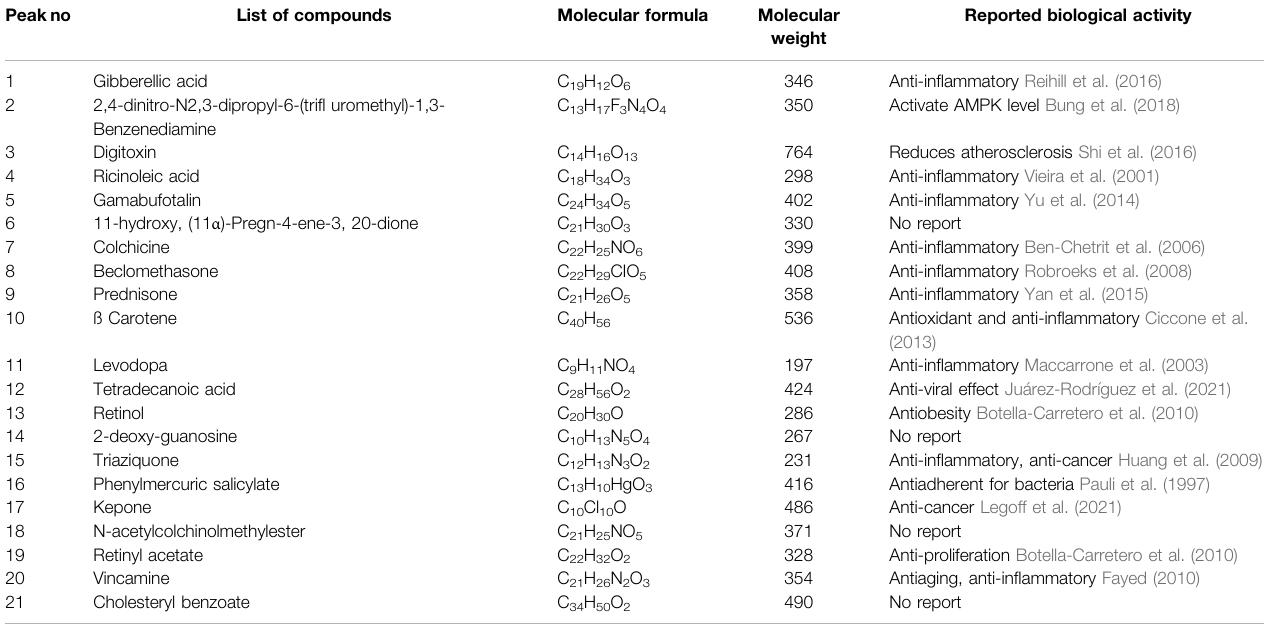
TABLE 2 | GC-MS phytochemical pro fi ling of basil seed methanol extract (BSME) showing 99 – 95% similarity in the database. Peakno List of compounds Molecular